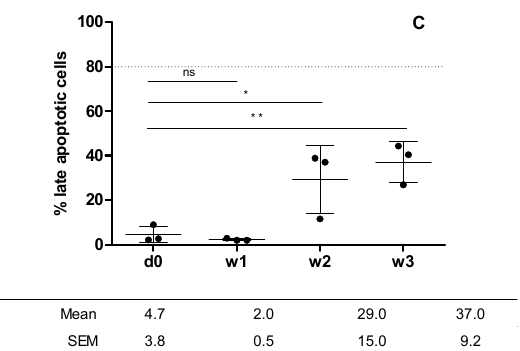
Figure 4. Cell viability of cartilage preserved at day 0 and at weeks 1, 2 and 3. Plotted from data obtained from flow cytometry analysis (Figure 3). Living cells (calcein+) ( A ); early apoptotic cells (Annexin V + 0 ( B ); late apoptotic cells (7-AAD+) ( C ). Statistical test: results are shown as mean ± SEM (n = 3) after performing non-parametric ANOVA followed by Dunnett’s post test. Differences between results are considered statically significant at a value of p < 0.05: * p < 0.05, ** p < 0.01. Differences between results considered non-statistically significant are indicated as